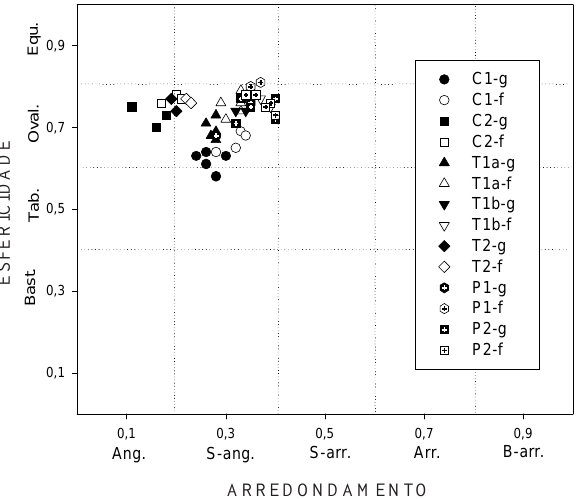
B-arr.Arr.S-arr.S-ang.Ang. Figura 4. Valores de arredondamento e esfericidade dos grãos grandes (g) e pequenos (f) nos materiais analisados na seqüência Latossolo- Espodossolo, sendo: Equ= eqüidimensional; Oval = ovalado; Tab = tabular; Bast = bastonado e Ang = angular; S-ang = subangular; S-arr = subarredondado; Arr = arredondado; B-arr = bem arredondado.